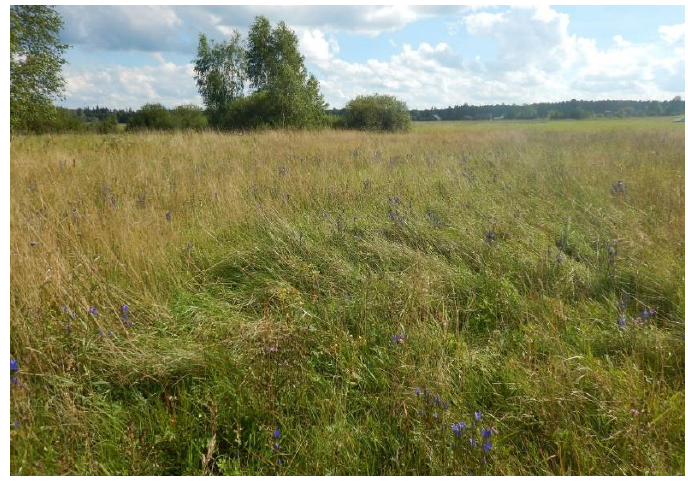
Figure 2. The study site of Phengaris alcon in the Białowieża Forest.